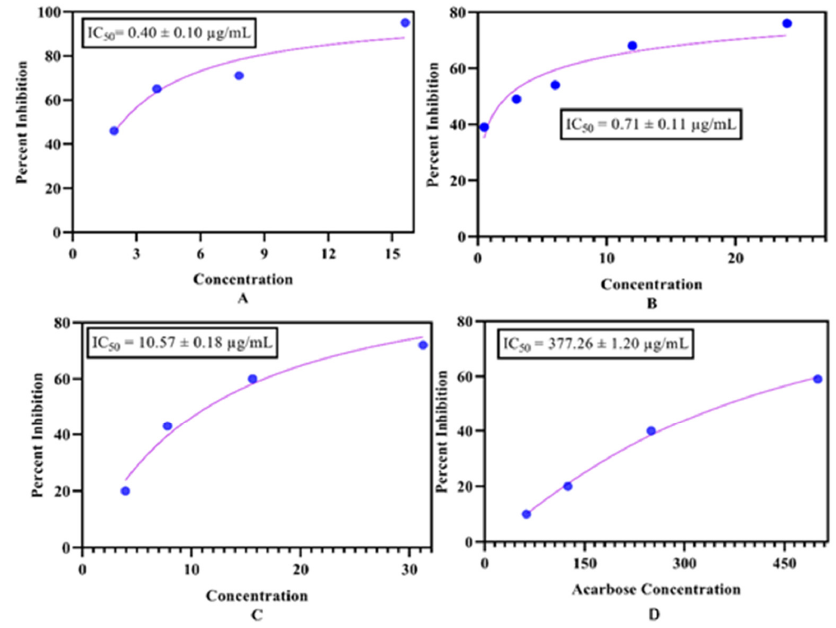
Figure 3. α -Glucosidase significance of the Ochradinus arabicus essential oil of ( A ) stems, ( B ) leaves, ( C ) flowers, and the ( D ) standard.